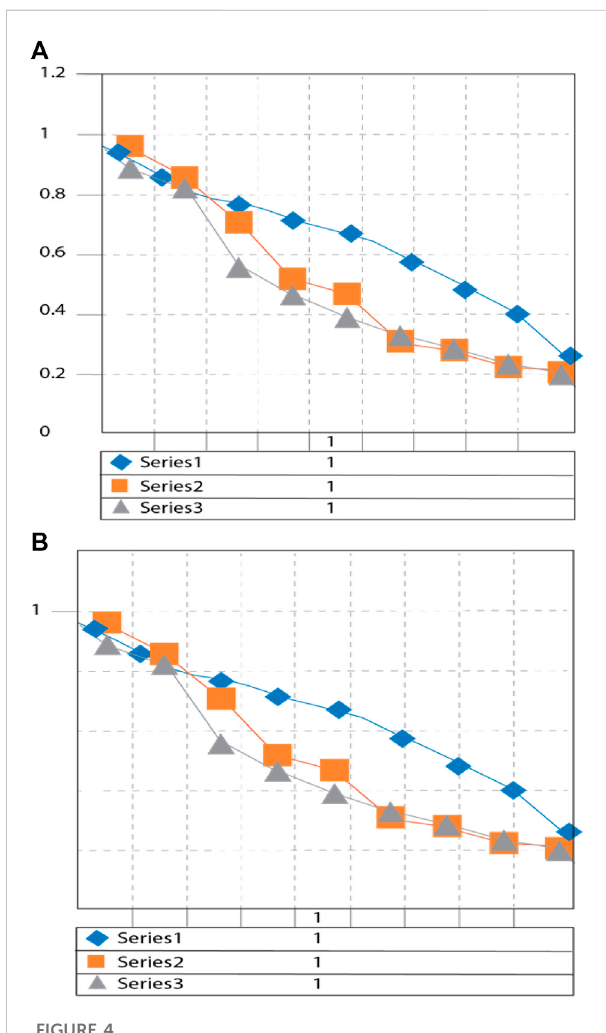
FIGURE 4 (A) Validation accuracy for the proposed algorithm. (B) Training accuracy for the proposed algorithm.